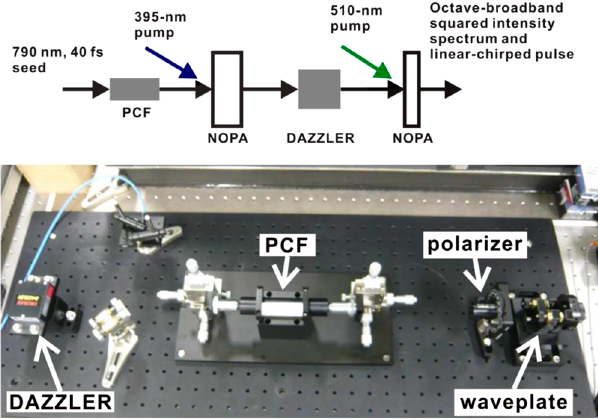
FIG. 4. Broadband probe laser